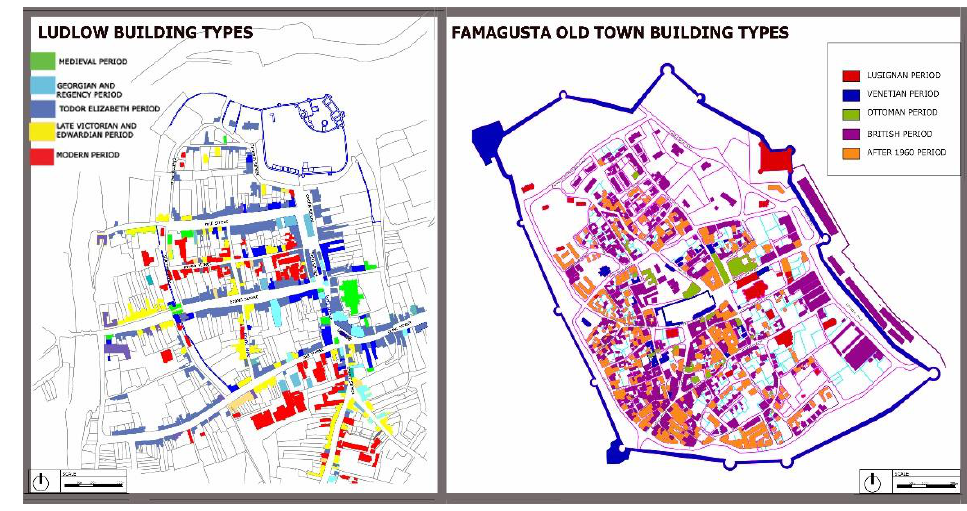
Figure 6 Ludlow and Famagusta Building Type